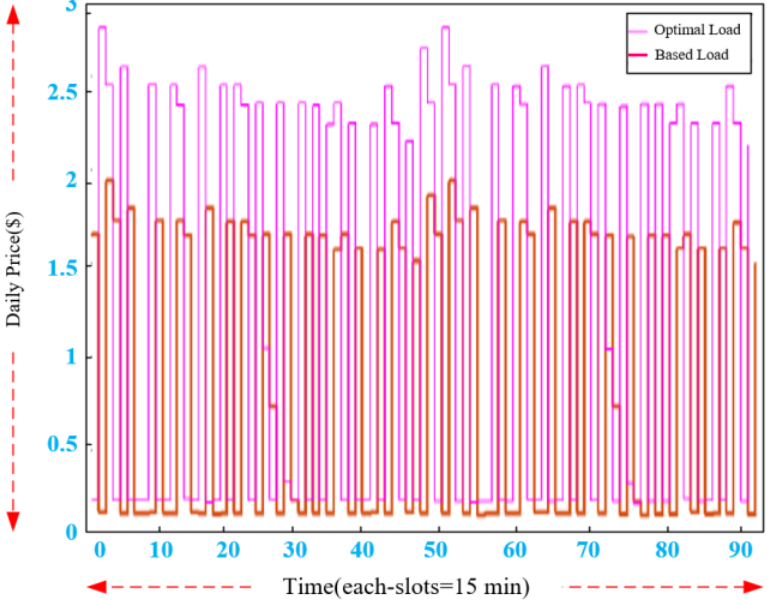
Figure 11. Comparison of AC consumption profile before and after application of the proposed